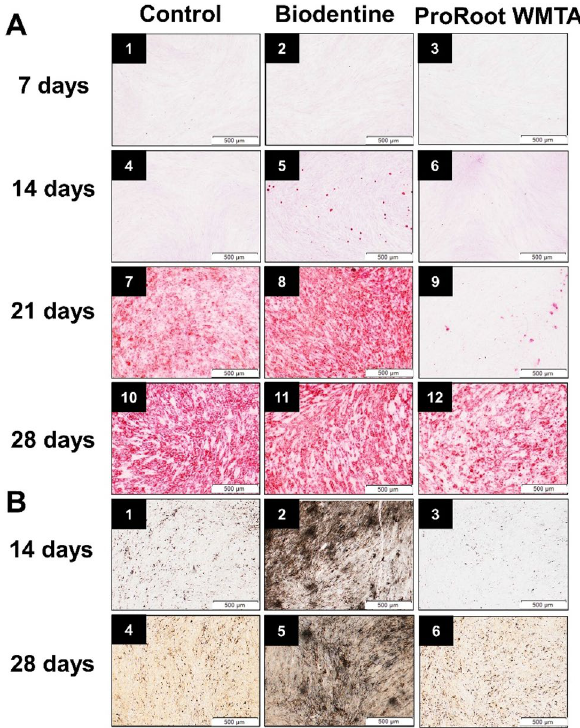
Figure 6. Mineralization assay to detect Ca 2+ deposits. Alizarin red staining of specimens after 7 (A1-3), 14 (A4-6), 21 (A7-9) and 28 (A10-12) days. Von Kossa staining of specimens after 14 days (B1-3) and 28 days (B4-6). Column 1, 2 and 3 are representative images of Control, Biodentine and ProRoot WMTA